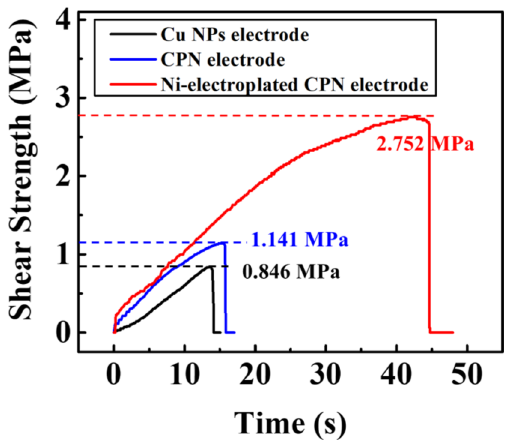
Figure 11. Shear strength tensile test between solder and electrodes. Ni-electroplating was performed under S-16